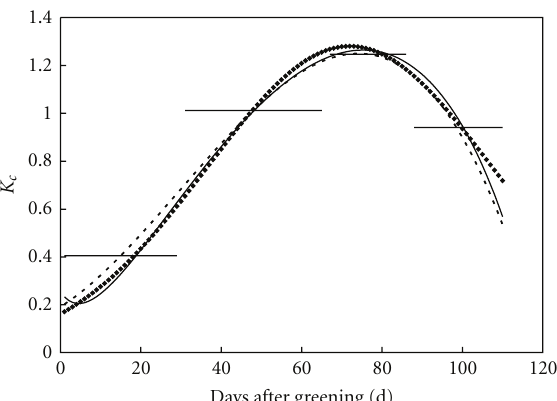
Figure 3: Daily crop coe ffi cient (dot), average ones at di ff erent growing stages (thick solid line), and disaggregated ones with methods 2 (dashed line) and 3 (solid